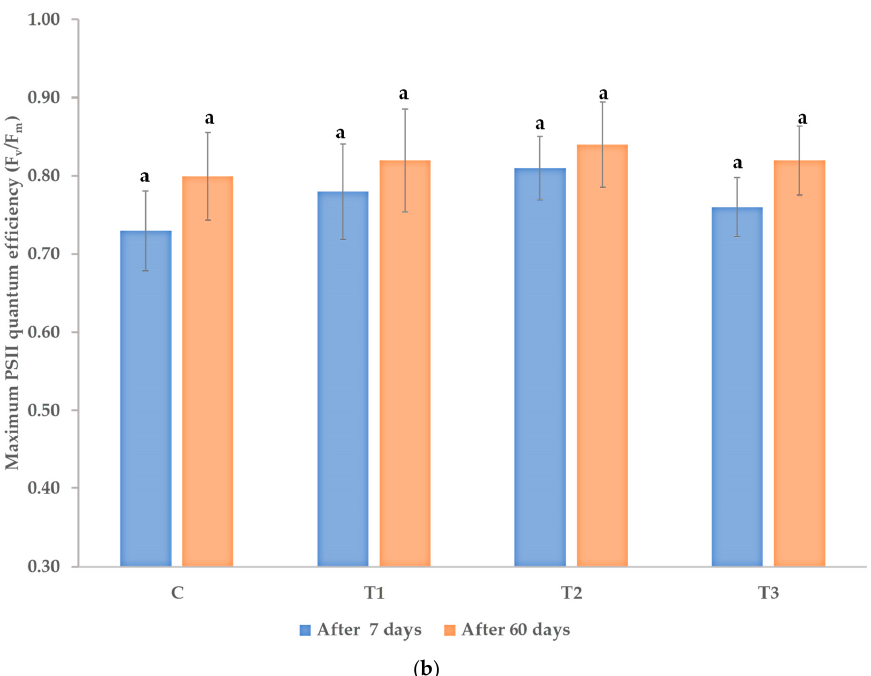
Figure 2. ( a ) Stomatal conductance (nmol/m 2 s) and ( b ) maximum PSII quantum efficiency of P. caerulea plants after seven days from the first treatment and after 60 days from the first treatment with plant biostimulants. C—control (no treatment with plant biostimulants, treated only with water);